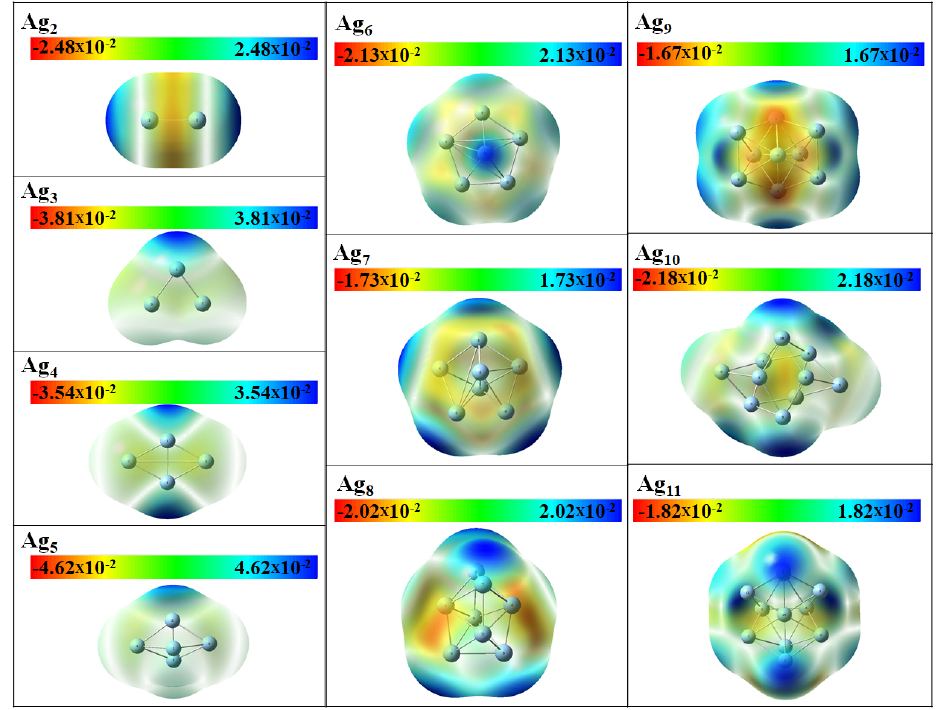
Figure 10. Molecular electrostatic (MEP) of the most stable Ag n ( n = 2–11) clusters according to the DFT calculations. The potential is shown on a surface of constant electron density (0.0004 a.u.) and the scales in each panel are given in